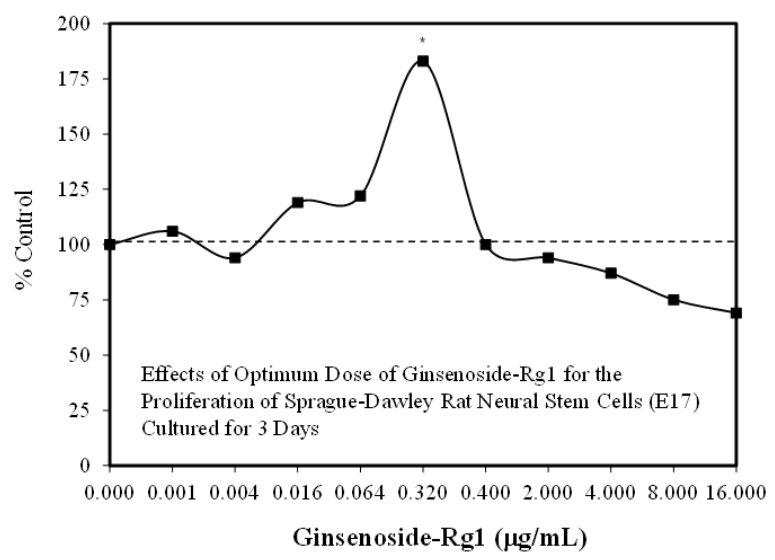
Figure 3. Effects of optimum dose of ginsenoside-Rg1 for the proliferation of Sprague–Dawley rat neural stem cells (E17) cultured for 3 days (source: [35]). * = statistically significant